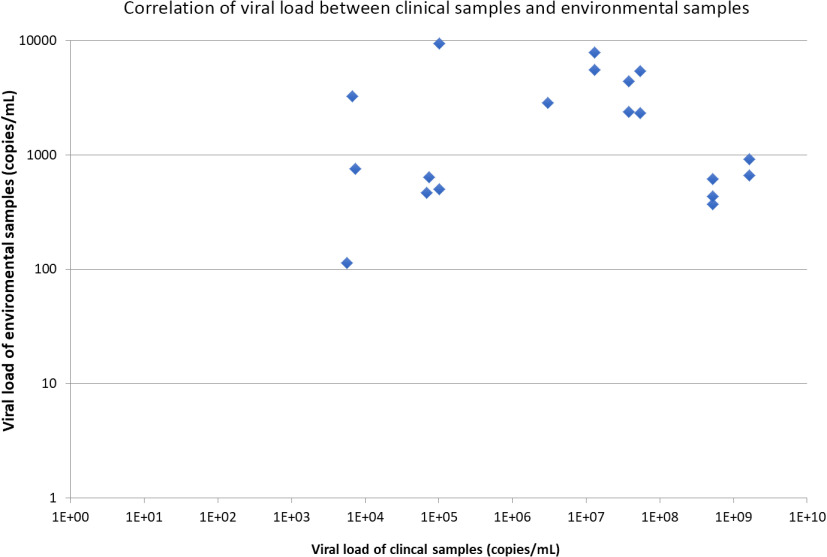
Correlation of viral load between clinical samples and environmental samples. Note. The viral load is expressed in logarithmic scale (base 10).